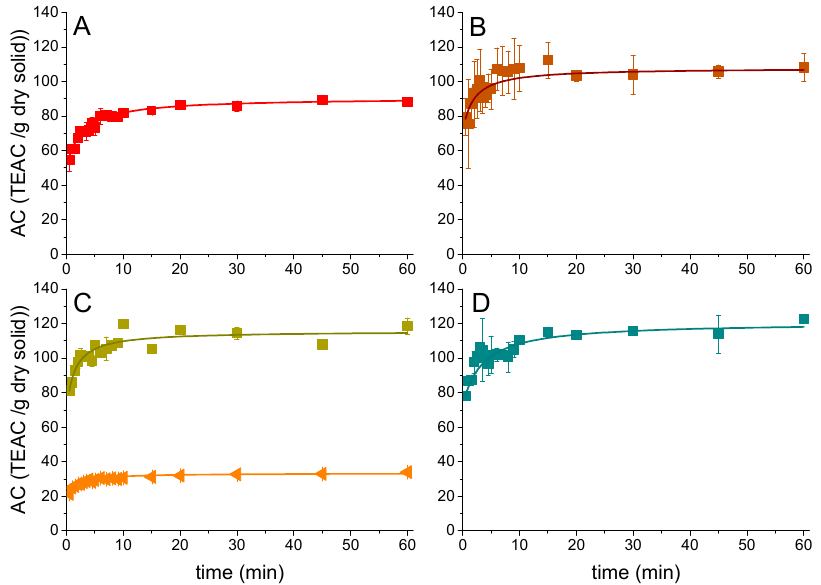
Figure 9. Antioxidant activity by DPPH method in points (data) and fit of the second-order kinetic model in lines. Results from grape pomace (GP) with a hydroalcoholic solution (ethanol/water 70%/30% v/v ) at several temperatures: ( A ) 25 °C, ( B ) 50 °C, ( C ) 70 °C (green line and points: ethanol 70%; orange line and points: ethanol 96%), and ( D ) 90 °C.